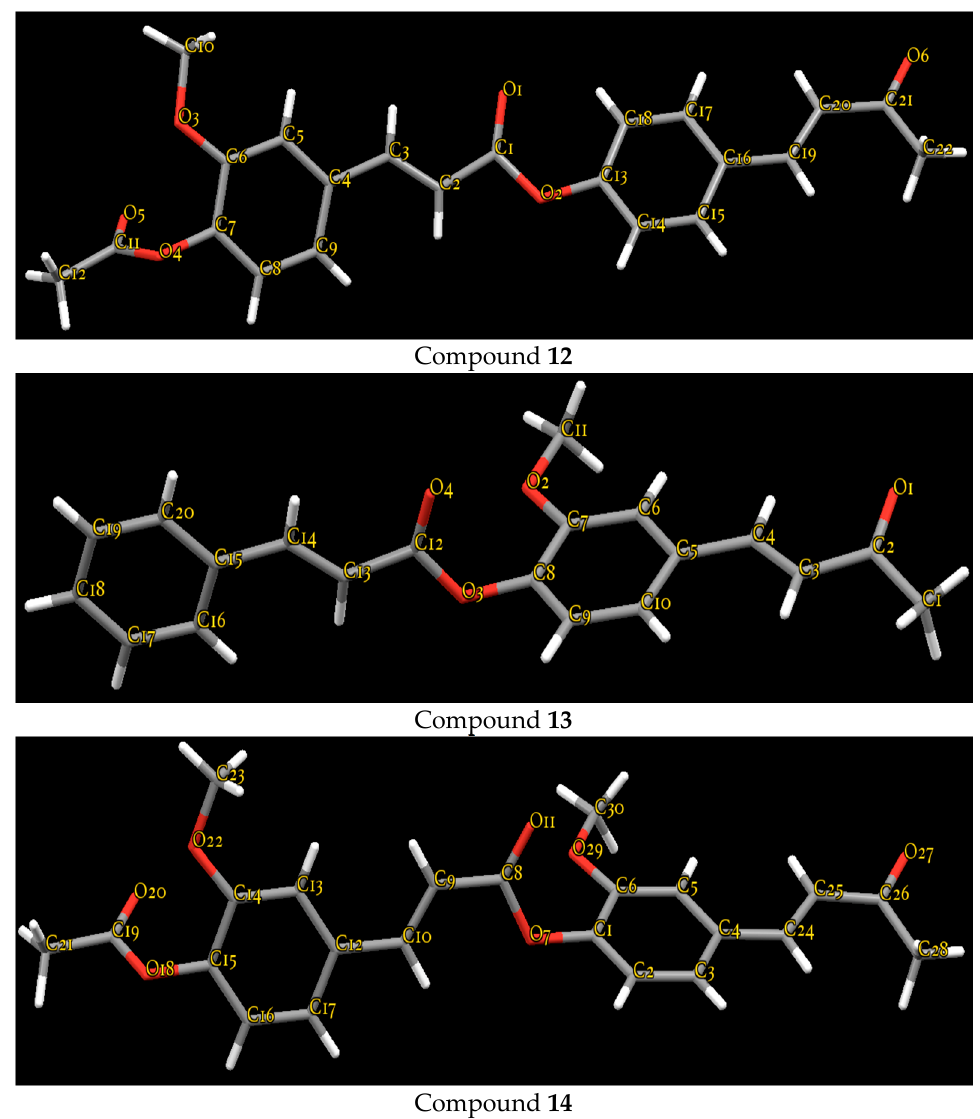
Figure 1. View of the molecular structure of compounds 7 , 8 , 9 , 10 , 12 , 13 , and 14 .